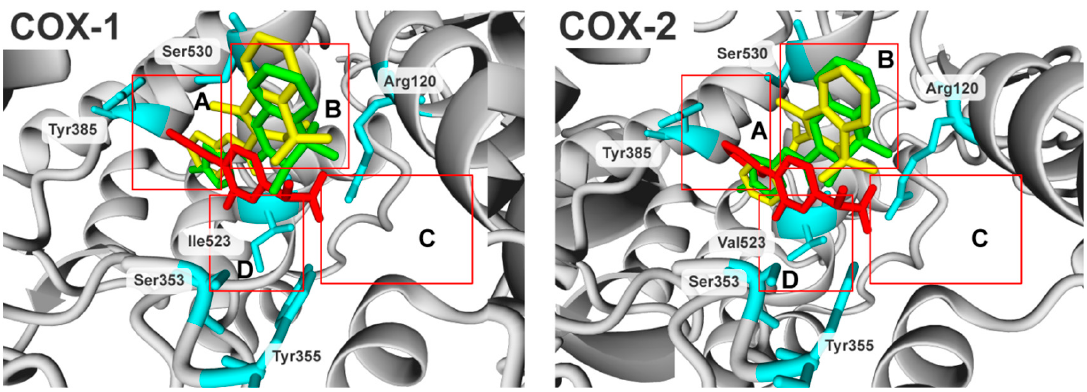
Figure 2. Illustration of four characteristic subdomains of the COX enzyme ligand-binding domain, indicated by red boxes, A, B, C and D. The flurbiprofen, meloxicam and piroxicam are coloured in red, green and yellow, respectively.